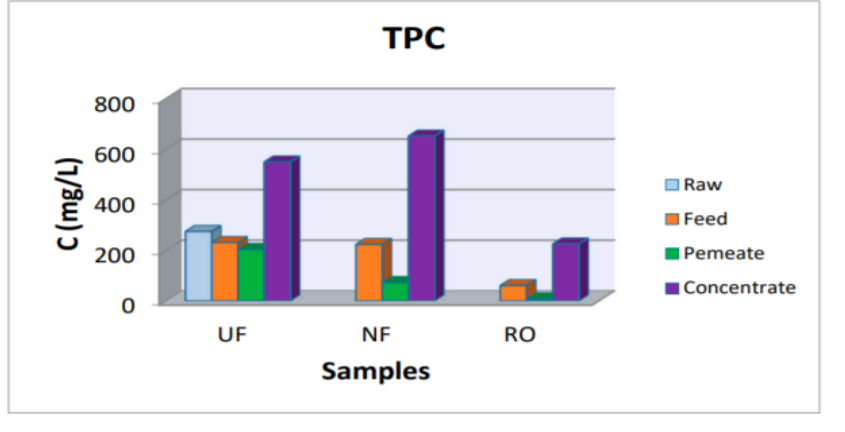
Figure 11. TPC concentration at the raw, feed, permeate and concentrate streams at the UF, NF, and RO membranes [96].